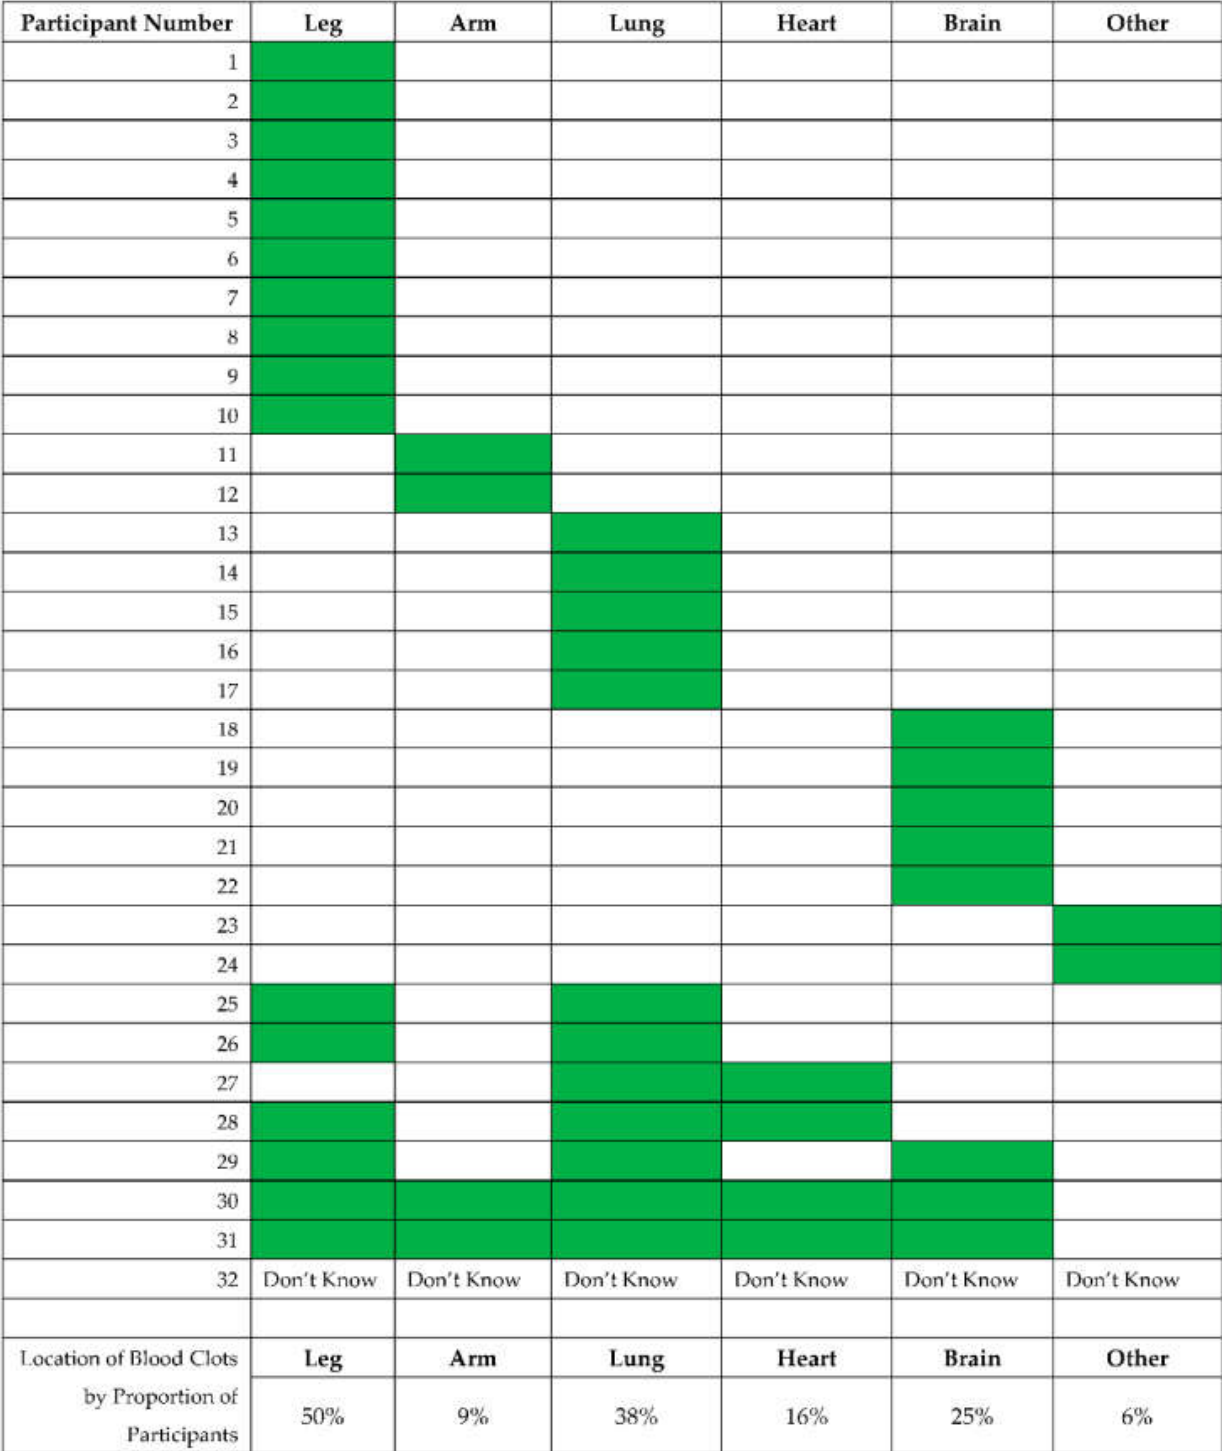
Figure 3. Location of blood clots in 32 PWS participants who reported a blood clot in the Thrombosis History Survey. Participants were able to indicate if they had blood clots in more than one location, and participants could also report a single clot or multiple clots in each location.